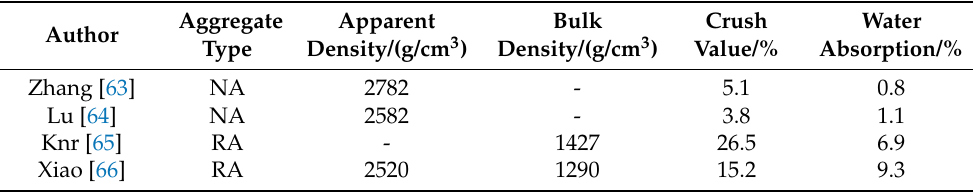
Table 2. Physical indicators of NAC and